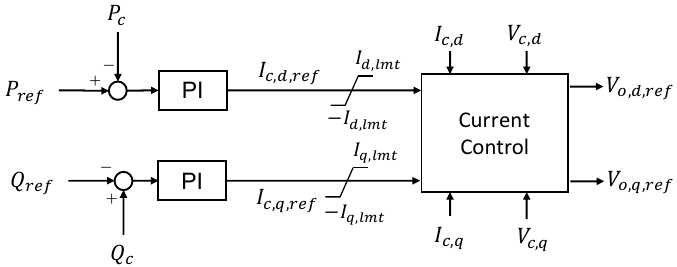
Figure 6. Controller model of the conventional IBR used in the simulation in Step 2.